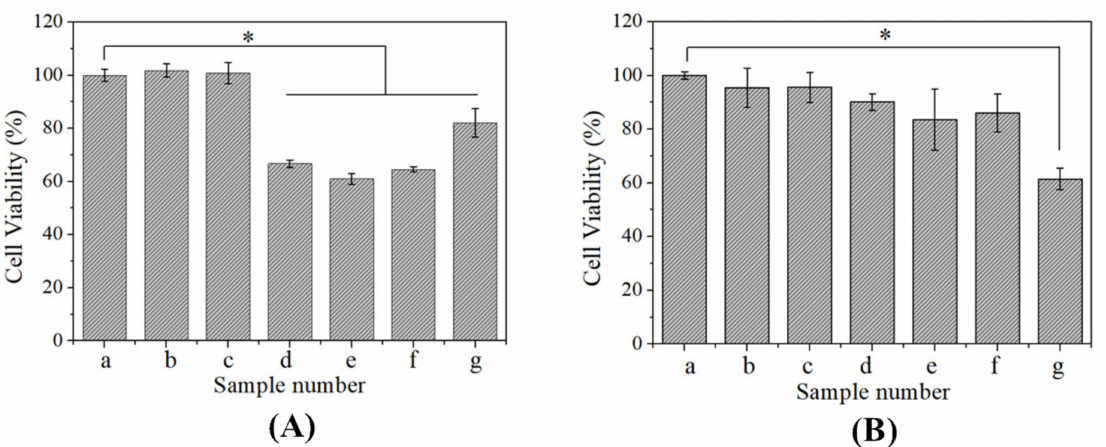
Figure 7. Viability of ( A ) A549 cells and ( B ) WI-38 cells after culturing with CBSF/pDNA complexes at predetermined weight ratios. a : Blank control; b : 2 µ g pDNA; c : 128 µ g CBSF; d – f : CBSF/pDNA complexes at w / w ratios of 64/2, 128/2, and 256/2, respectively. g A 25 kDa PEI/pDNA complex at a w / w ratio of 10/2. Each value represents the mean ± SD of three separate experiments, n = 3, * p <